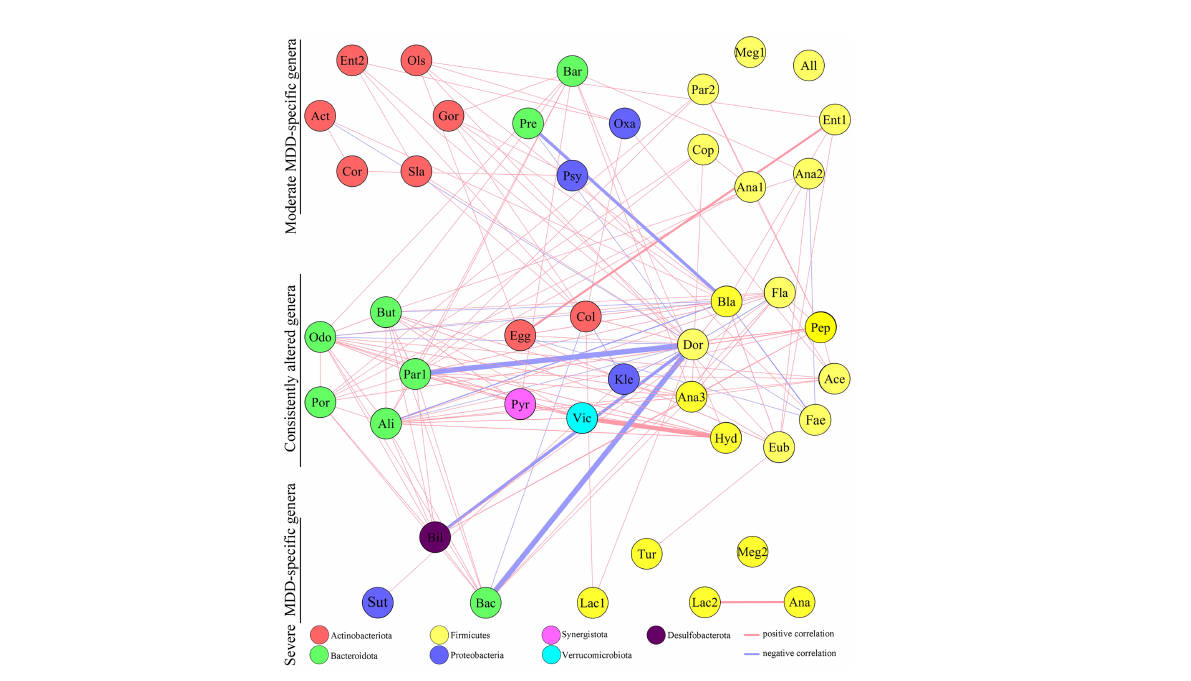
FIGURE 2 | Co-occurrence network showing microbial changes in moderate and severe MDD patients. The microbial genera changed in moderate or severe MDD were identi fi ed by OPLS-DA. In total, 63 differential genera were identi fi ed in the two groups. Nineteen of 63 genera were consistently altered in both moderate and severe MDD patients relative to HC, and 17 and 8 genera were speci fi c to moderate MDD alone and severe MDD alone, respectively. Compared to HC, moderate MDD was mainly characterized by altered covarying genera assigned to phylum Firmicutes, Actinobacteriota, and Bacteroidota, while severe MDD was mainly characterized by altered covarying genera assigned to phyla Firmicutes and Bacteroidota. Lines between nodes indicate Spearman ’ s correlation > +0.30 (light red) or < − 0.30 (light blue)); line thickness indicates p value (p <